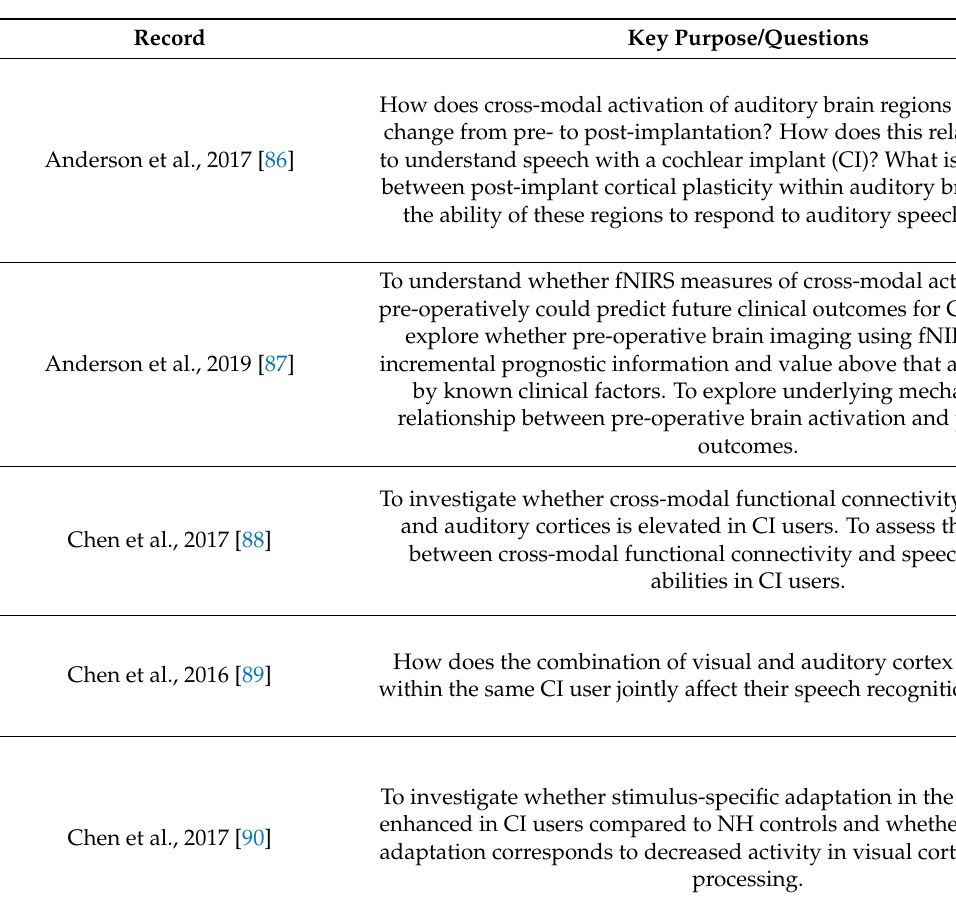
Table 2. Research questions and key results from the eight included